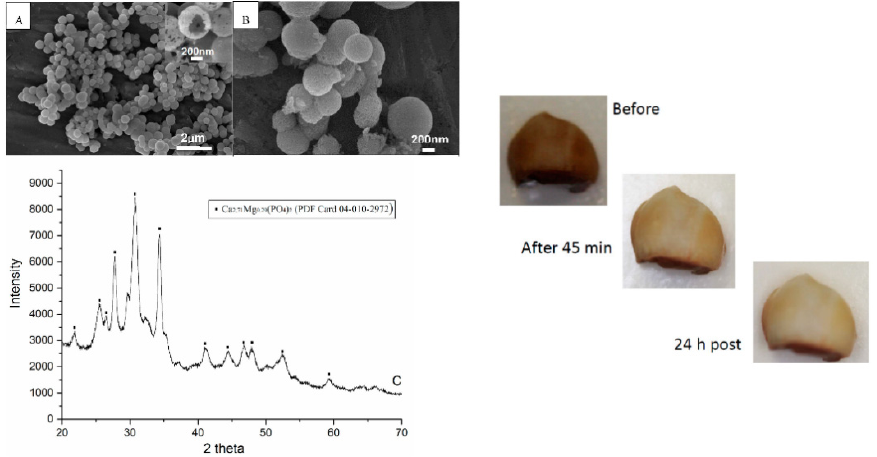
Figure 6. Left : ( A , B ) Scanning electron microscopy (SEM) micrographs and ( C ) powder X-ray diffraction (PXRD) patterns of TCP microspheres. Right : ex vivo bleaching effect of the microspheres containing hydrogen peroxide and carbamide peroxide. (Reprinted from [109].)